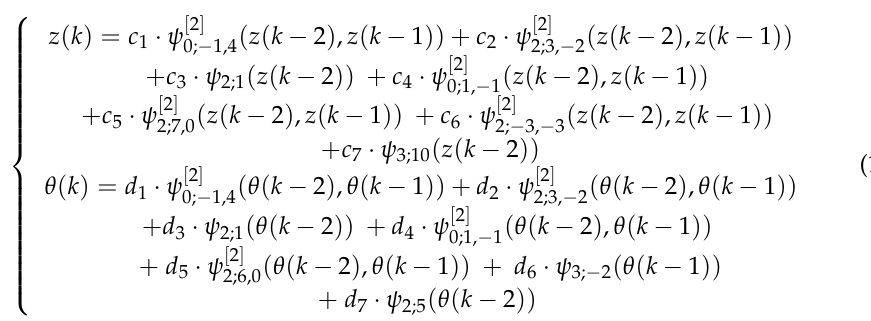
Table 9. The coefficients in Equation